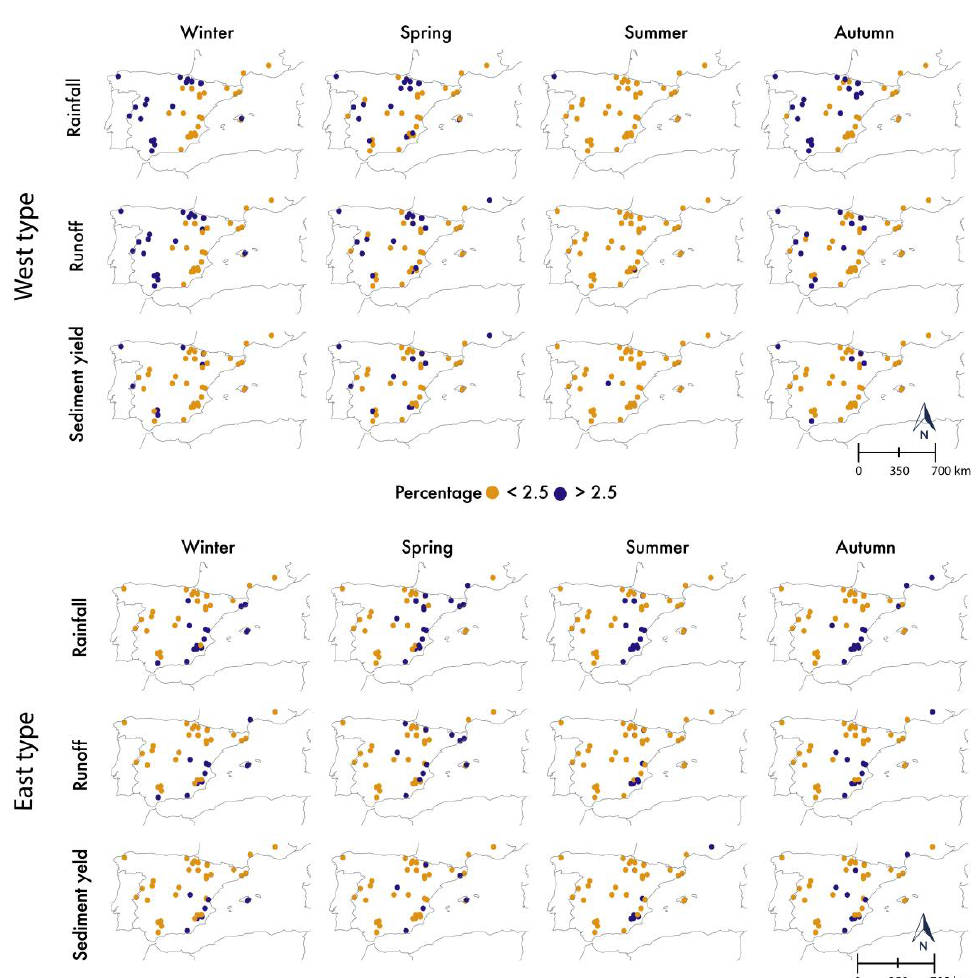
Figure 4. Spatial distribution of the percentage of rainfall, runoff and sediment yield in the west (W) and east (E) weather types for each season. The 2.5% value represents the uniform distribution of 10 WTs and 4 seasons.